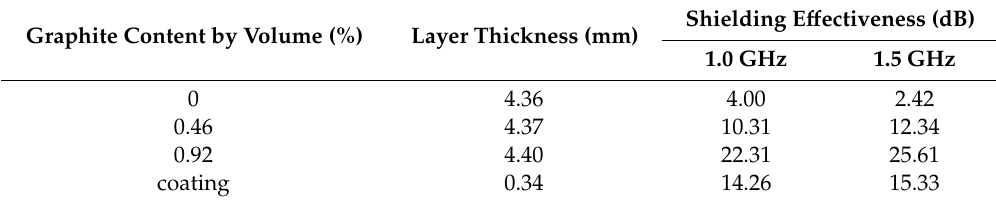
Table 1. Shielding e ff ectiveness of tested samples with colloidal graphite. Graphite Content by Volume (%)